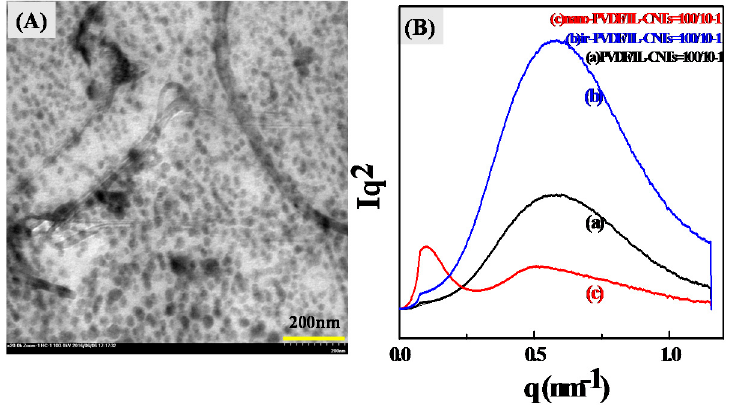
Figure 3. ( A ) TEM image of nano-PVDF/IL-CNTs (100/10-1) and ( B ) Small-angle X-ray scattering (SAXS) patterns of PVDF/IL-CNTs (100/10-1), irradiated-PVDF/IL-CNTs (100/10-1) and nano-PVDF/IL-CNTs (100/10-1) samples.